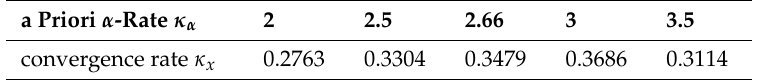
Table 2. Error rates κ x by regression for x † ≡ 1 and varying a priori exponents κ α .